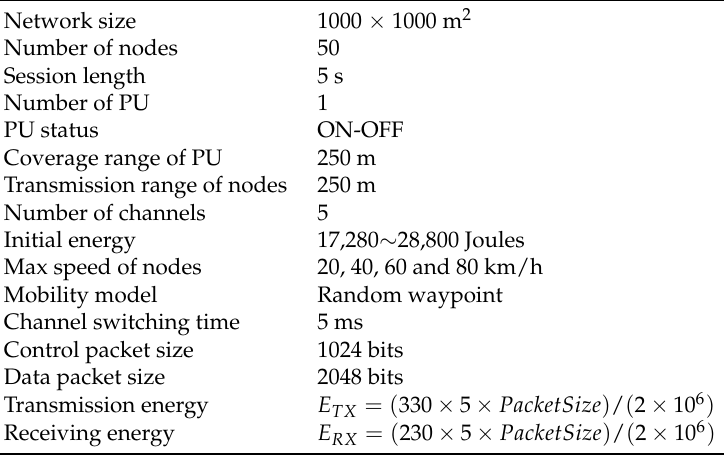
Table 2. Simulation Environments and